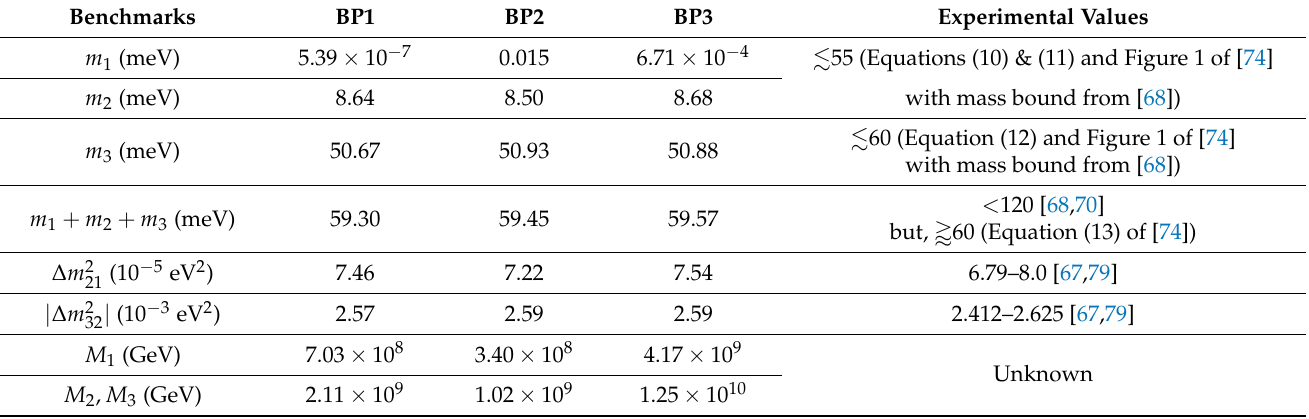
Table 2. The computed values of neutrino masses for normal hierarchy ( m 1 < m 2 < m 3 ), the sum of light neutrino masses, and light neutrino mass squared differences. These neutrino masses are